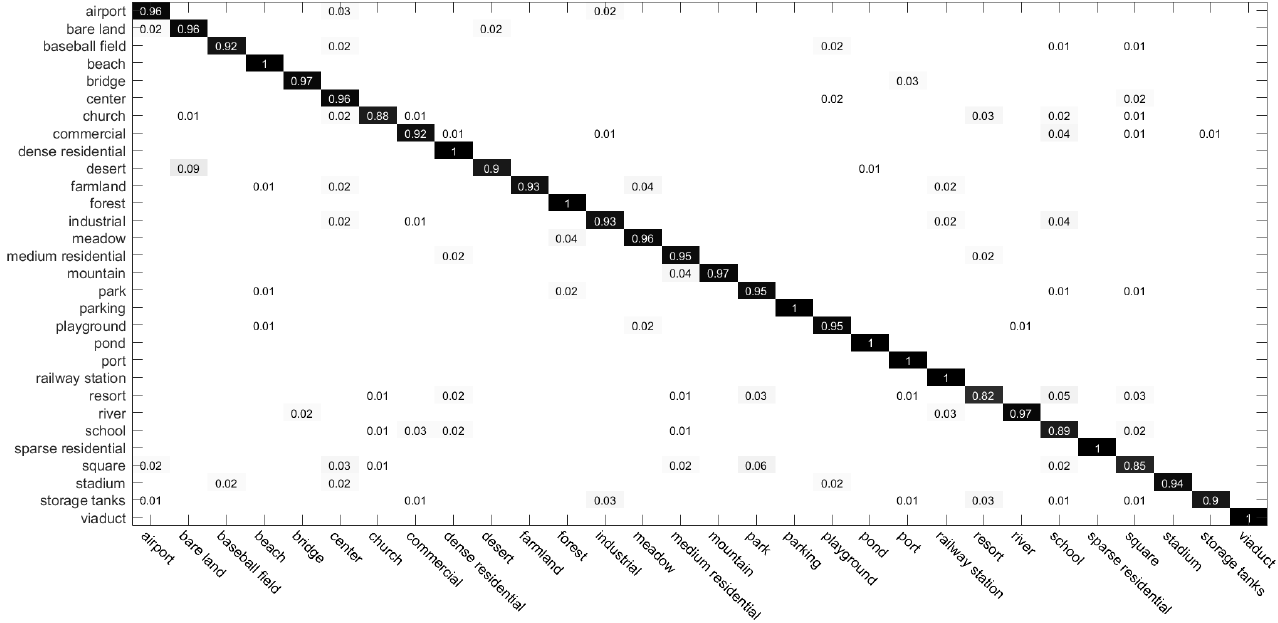
Figure 7. Confusion matrix of the proposed method on the UC Merced dataset under the training ratio of 10%.